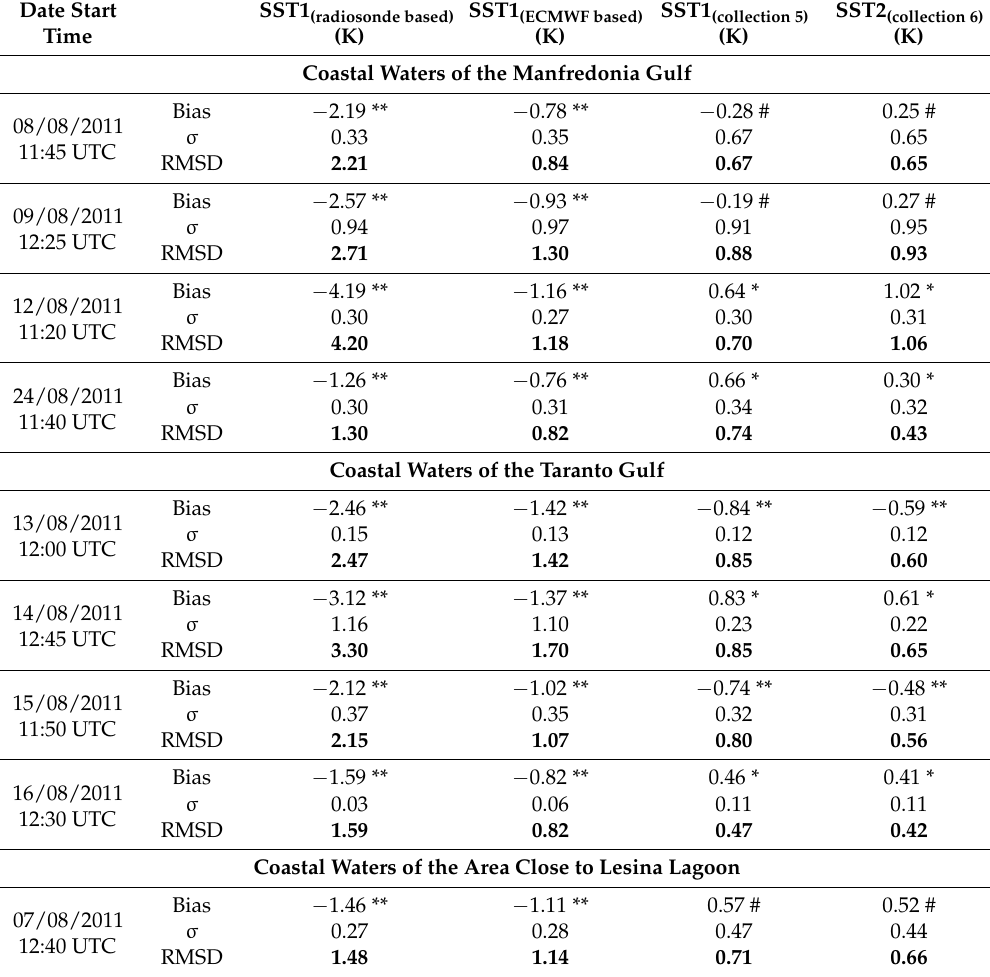
Table 2. Values of root-mean-square deviation (RMSD), bias, and σ between SST skin data and SST1 (radiosonde based) , SST1 (ECMWF based) , and SST1 (collection 5) measurements.